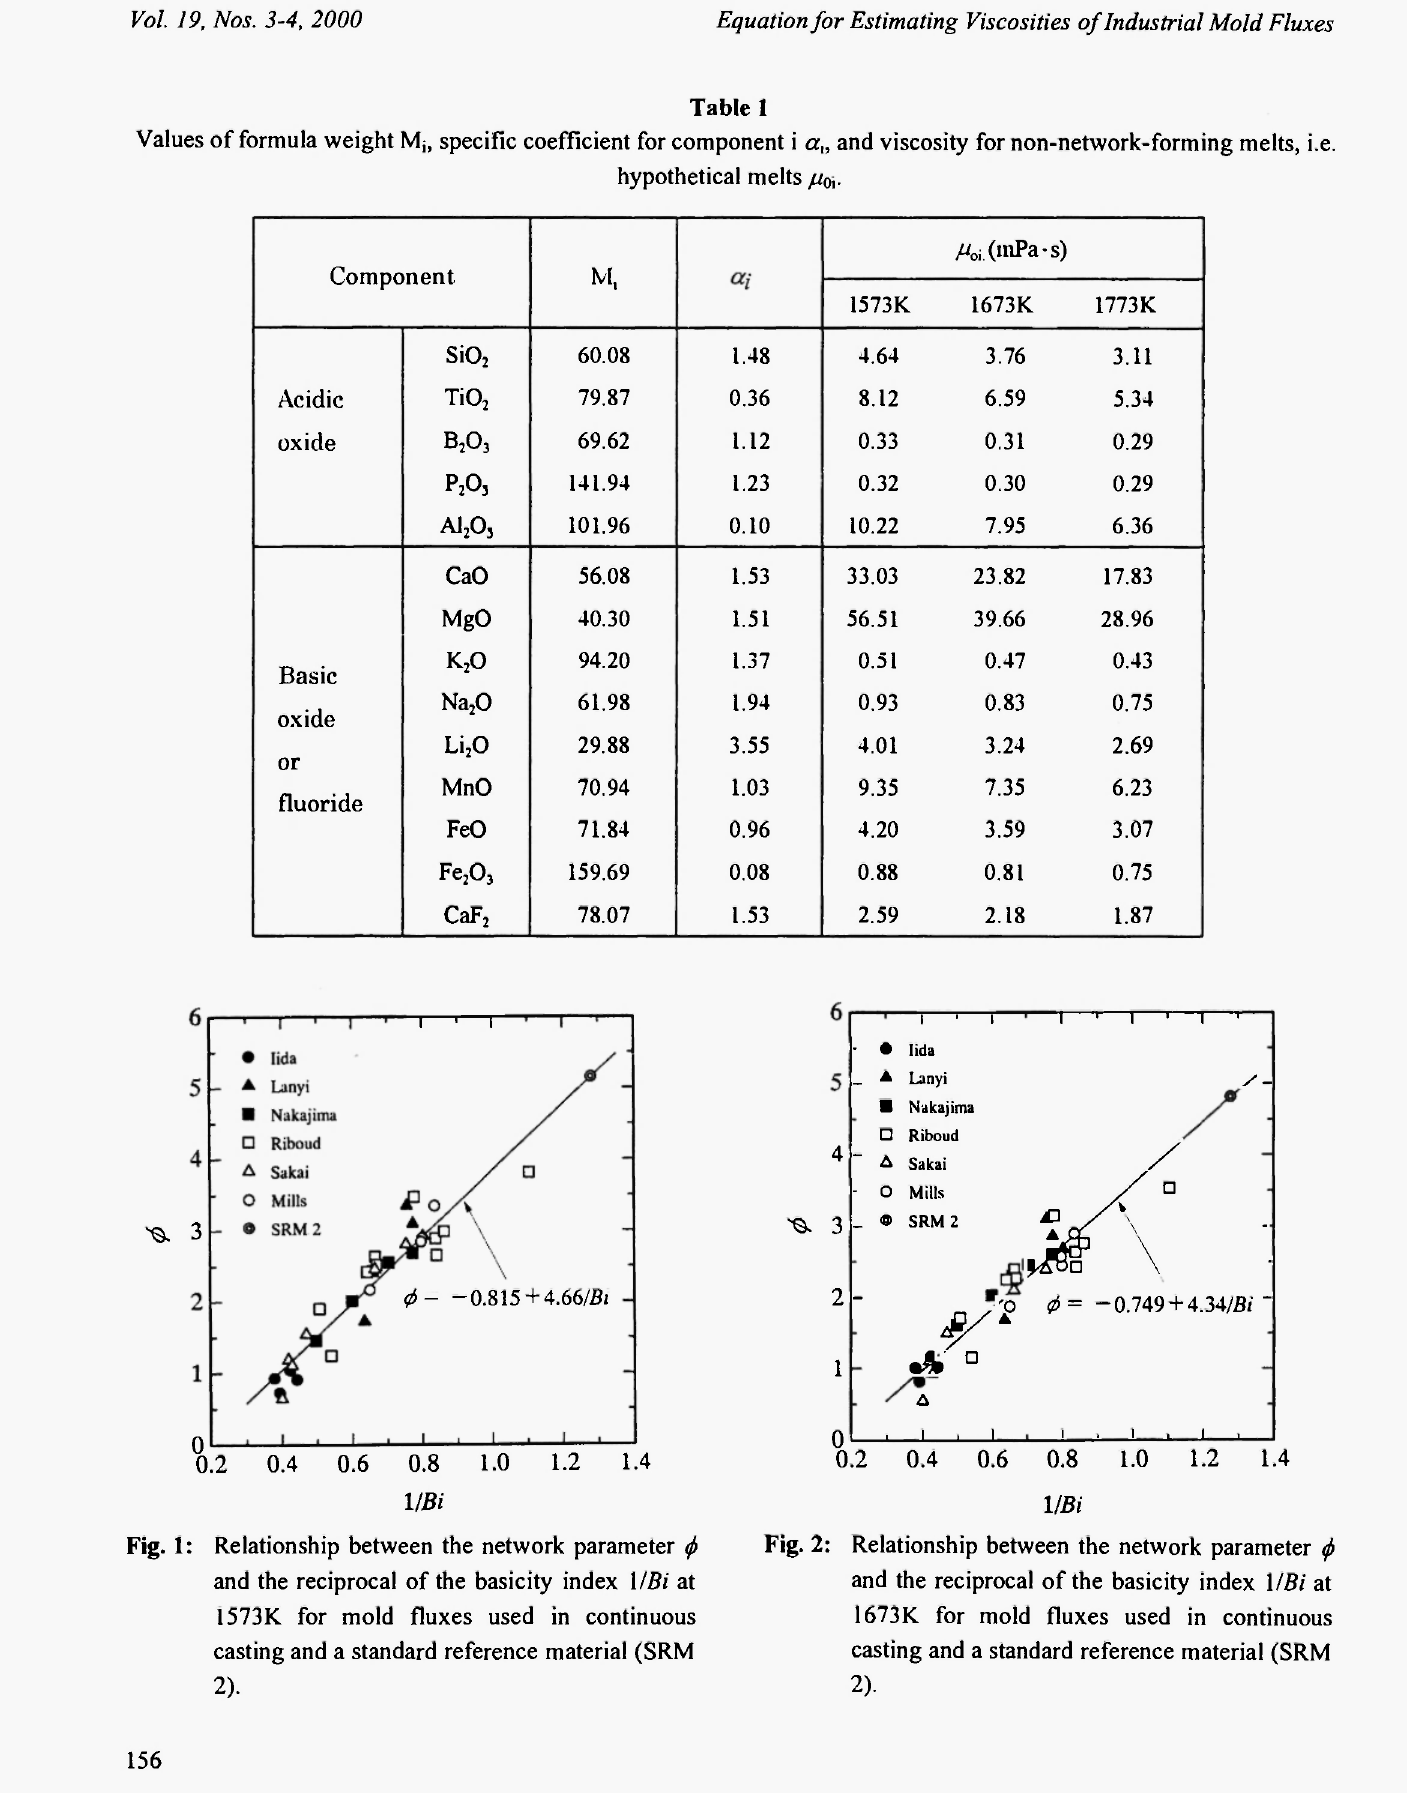
Values of formula weight Mj, specific coefficient for component i a„ and viscosity for non-network-forming melts, i.e. hypothetical melts μ 0ι .